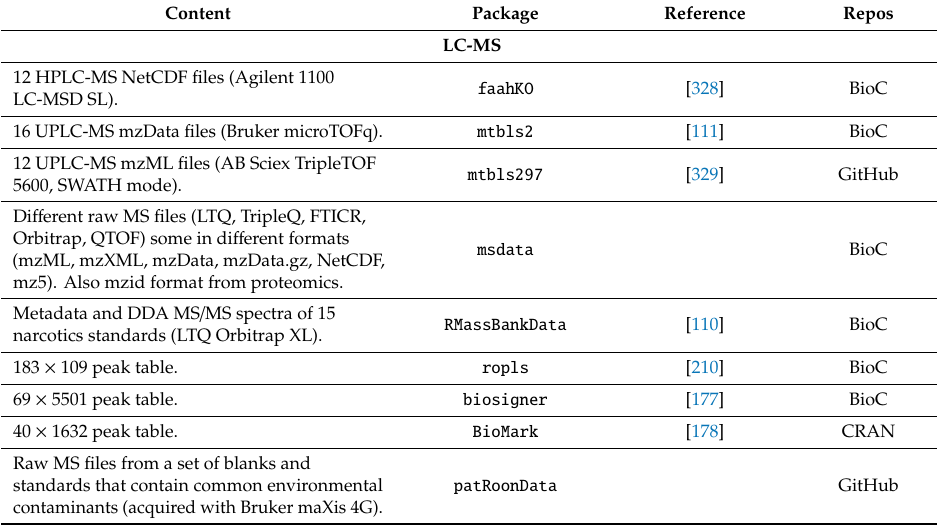
Table 12. Metabolomics data sets packaged as R